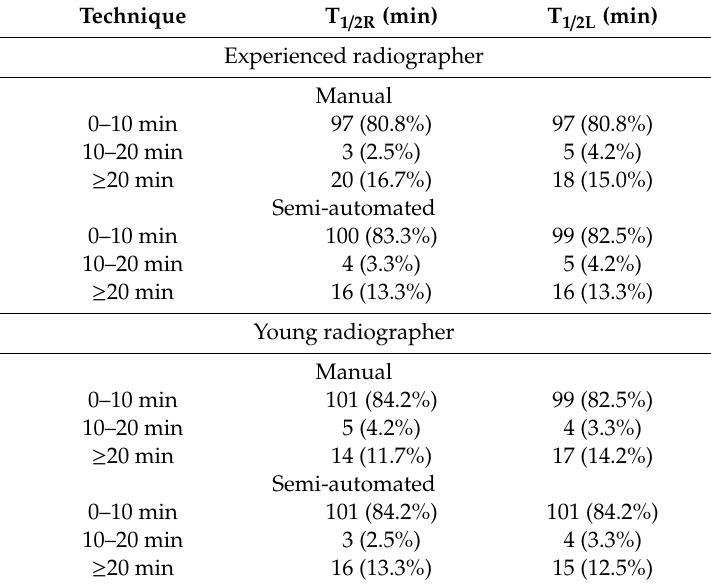
Table 3. Numbers of patients (%) classified in three groups based on T 1 / 2 values. The patients were grouped as follows: 0–10 min, 10–20 min and ≥ 20 min.